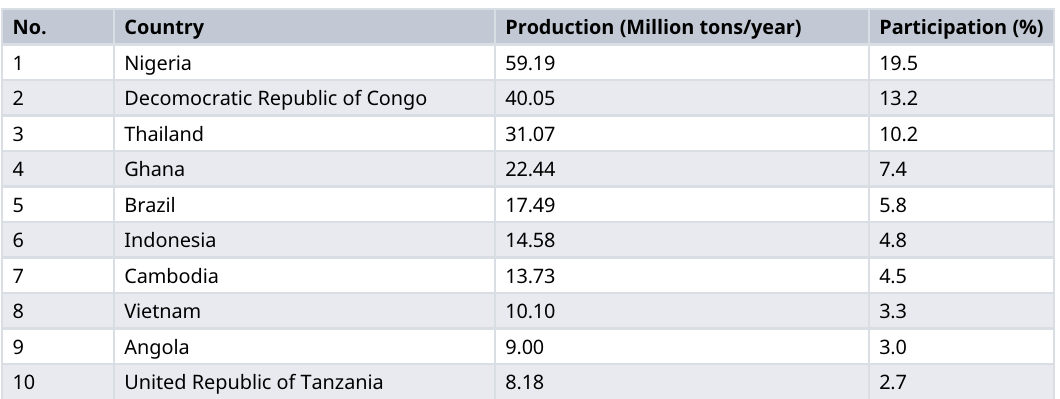
Table 1. Main producing countries of